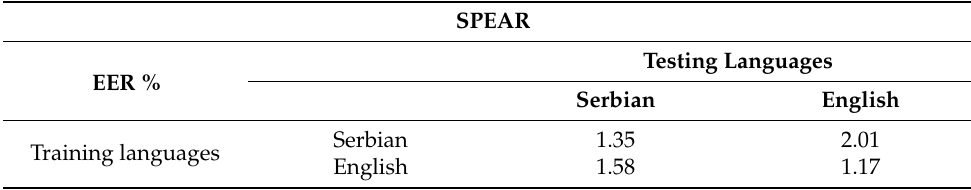
Table 2. The best SPEAR performance, as measured by EER, compared to the languages used.